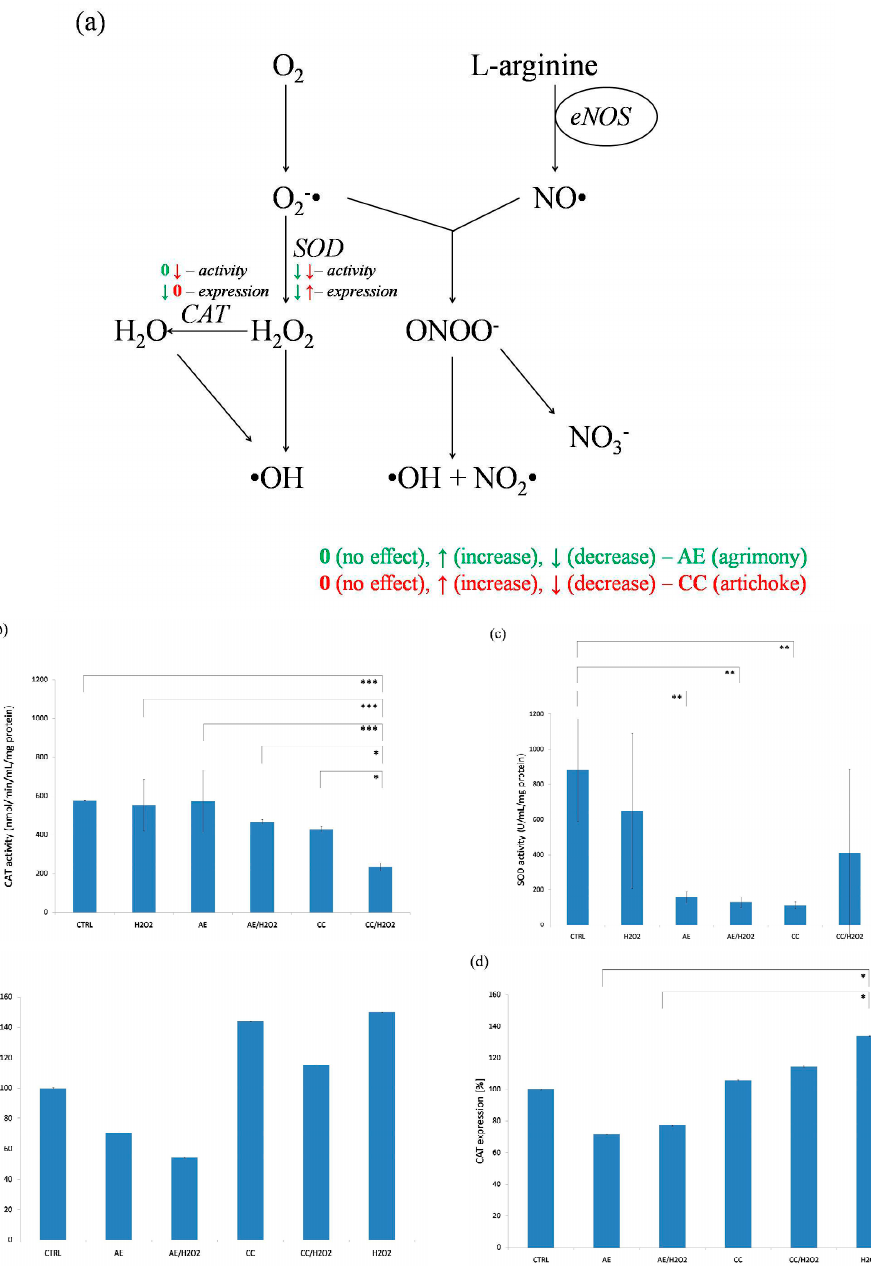
Figure 2. ( a ) Scheme of plant’s effects on NO degradation by superoxide (0—no effect, ↑ —increased activity/expression, ↓ —decreased activity/expression; AE—green, CC—red); ( b – e ) effect of agrimony and artichoke on activity of CAT ( b ) and SOD ( c ) and expression of CAT ( d ) and SOD ( e ) (*** p < 0.001, ** p < 0.01, * p < 0.05).